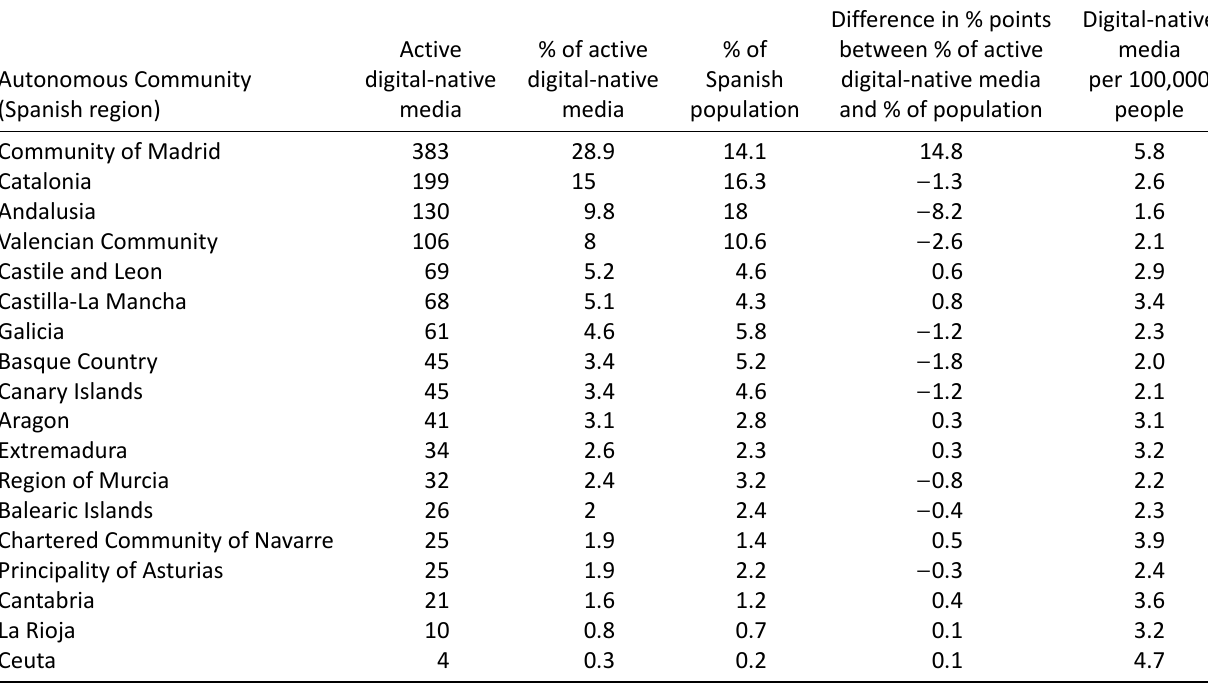
Table 6. Geographical location of active digital-native media (N = 1,382, November